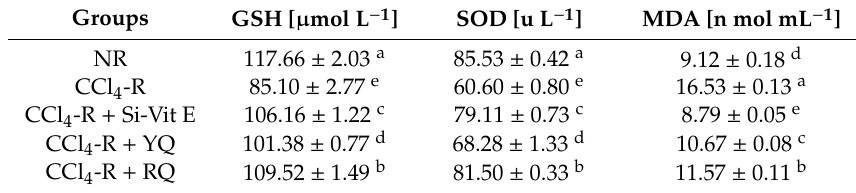
Table 6. E ff ects of quinoa extracts on oxidative stress biomarkers in rats with CCl 4 -induced oxidative stress (mean ± SE), n =